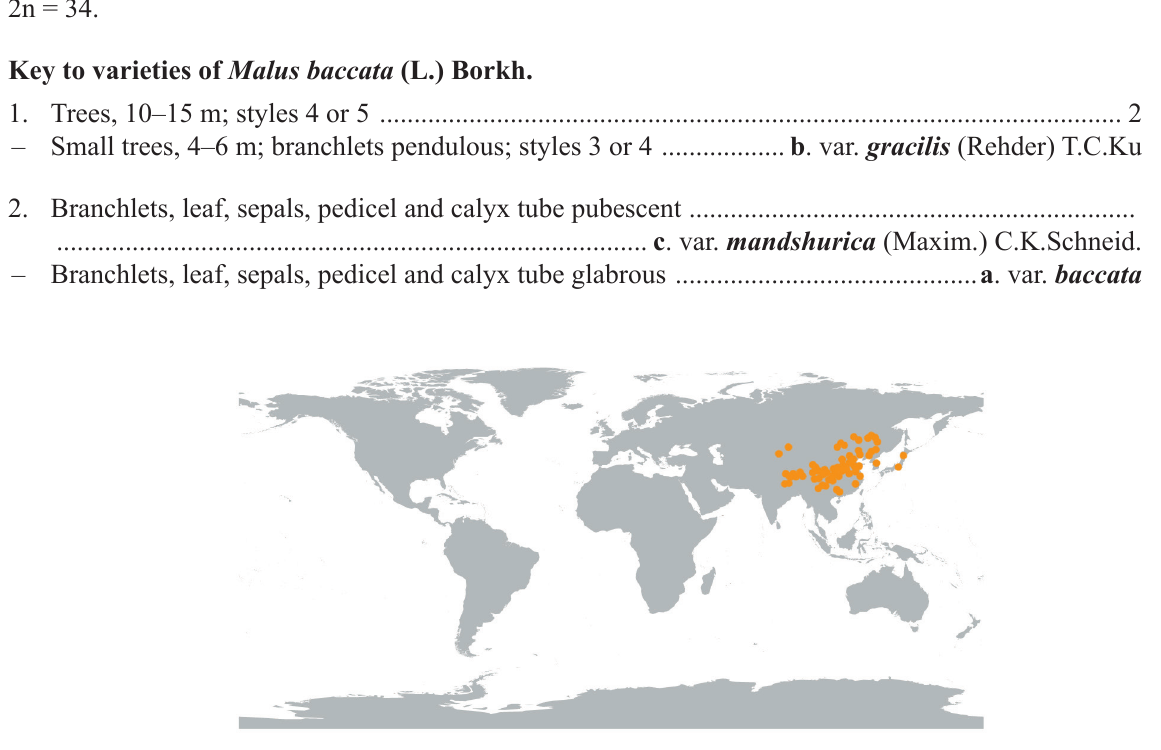
Fig. 5. Distribution of Malus baccata (L.) Borkh